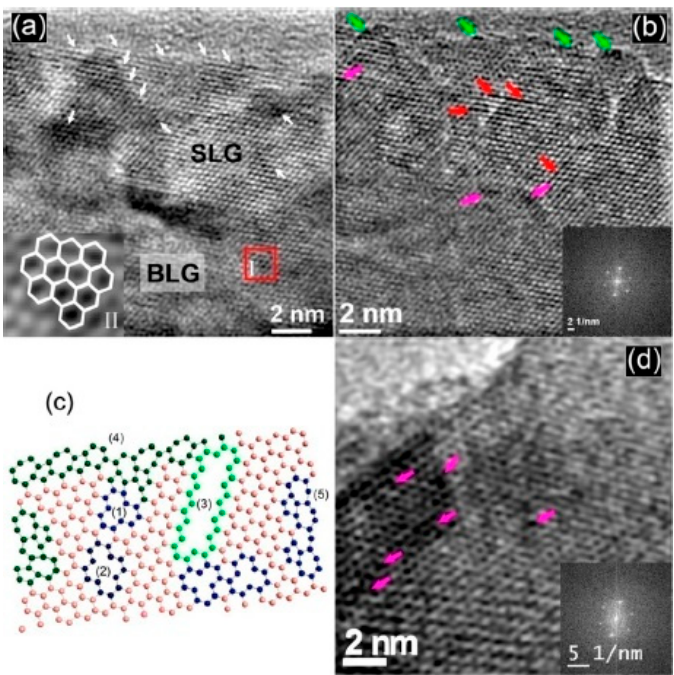
Figure 7. ( a ) High Resolution Transmission Electron Microscope (HRTEM) image of single-layer (SLG) and bi-layer (BLG). ( b ) HRTEM image of graphene with the corresponding Selected Area Electron Diffraction (SAED) pattern in the inset; various colored arrows indicate the presence of different kinds of defects (green, edge defects; red, line defects; pink, vacancies). ( c ) Schematic of the molecular model of a graphene sheet with various defects, such as (1) single vacancy, (2) bi vacancies, (3) line defects, (4) zigzag, and (5) arm chair edge reconstructions highlighted by colored carbon atoms on the basal plane ( d ) HRTEM image of Graphene gold (GRAu) showing the additional vacancy defects (pink arrows) after Au deposition (Reprinted (adapted) with permission from [23] Copyright © 2014, American Chemical Society).